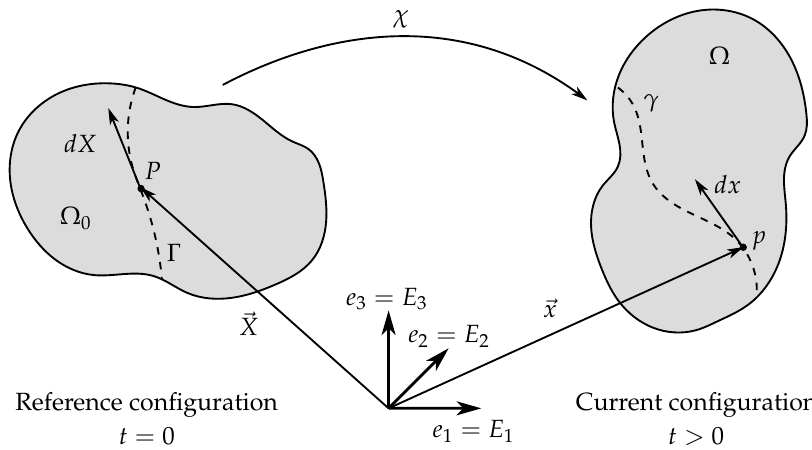
Figure 1. Visualization of different descriptive approaches for the movement and deformation of a continuum body in space by two selected configurations in time ( t = 0 reference configuration, t > 0 current configuration). Describing a movement or deformation relative to the coordinates of a reference configuration (undeformed) is called Lagrangian description, while describing it relative to the coordinates of a current configuration (deformed) is called Eulerian description (adapted from [41]). All variables with regard to the current configuration will be marked lower case, while all variables with regard to the reference configuration will be represented by upper case letters or by the index l